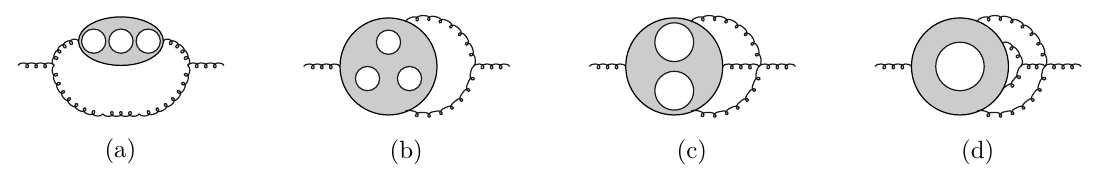
Figure 1 . The grey blobs denote examples of multi-loop multi-gluon subgraphs contributing at the four loop order, which contain insertions of the gauge invariant operator, and whose UV-divergences lead to mixing with unphysical operators under